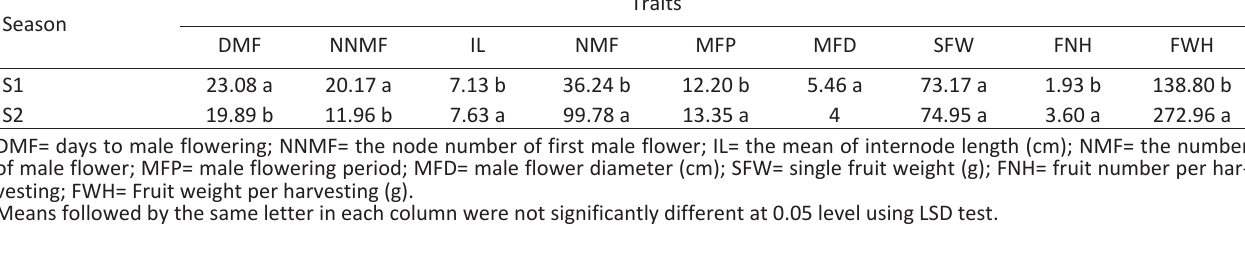
Table 3 - The effects of various chemical treatments application on studied traits in cucumber